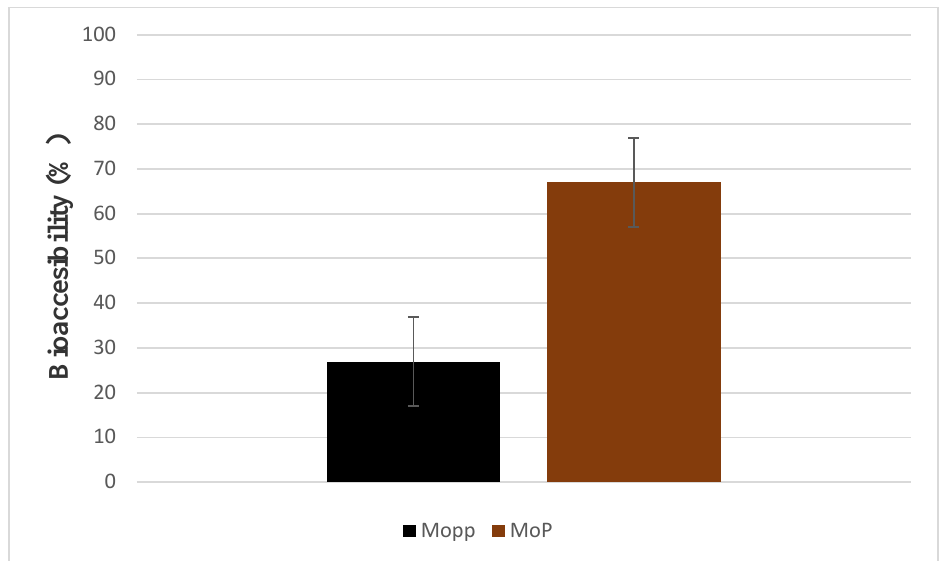
Figure 7. Bioaccessibility comparison of Mopp and MoP after exposure to simulated gastrointestinal conditions.